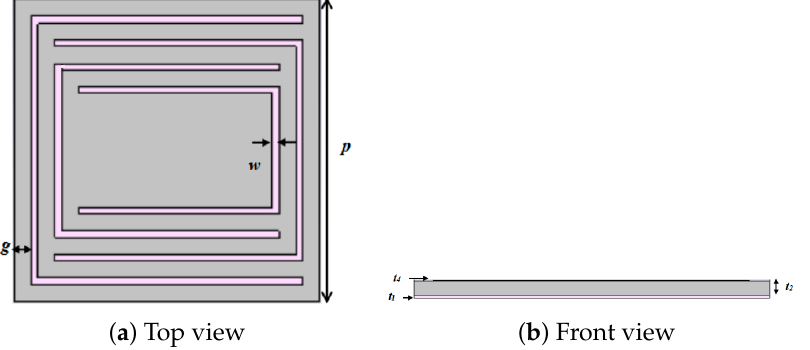
Figure 1. Proposed absorber ( a ) Unit cell of patches with p = 180 µ m, w = 4 µ m and g = 10 µ m. ( b ) Front view of the absorber with t 1 = 1.5 µ m, t 2 = 7 µ m and t 4 = 0.5 µ